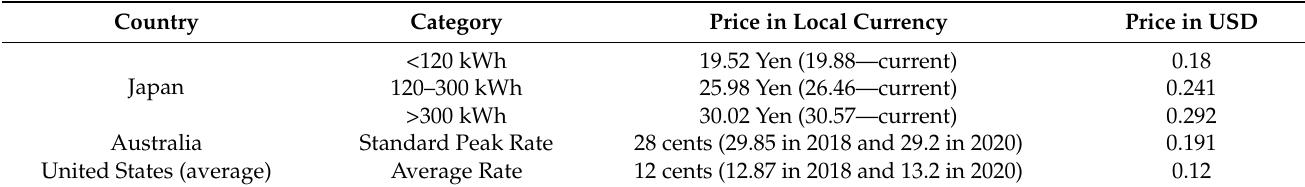
Table 7. Electricity tariff Rates in Japan, Australia and the United States.